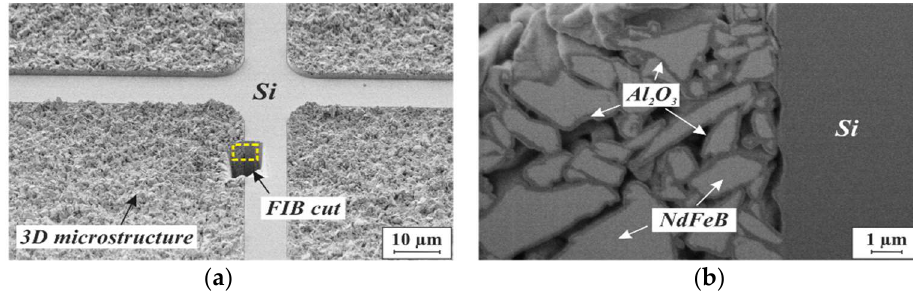
Figure 8. SEM micrographs of an FIB cut through a porous 3D microstructure agglomerated from NdFeB powder with 5 µm mean particle size by 75 nm ALD-Al 2 O 3 : ( a ) FIB preparation overview. ( b ) Detailed side view of the FIB cut area within the yellow frame in ( a ).